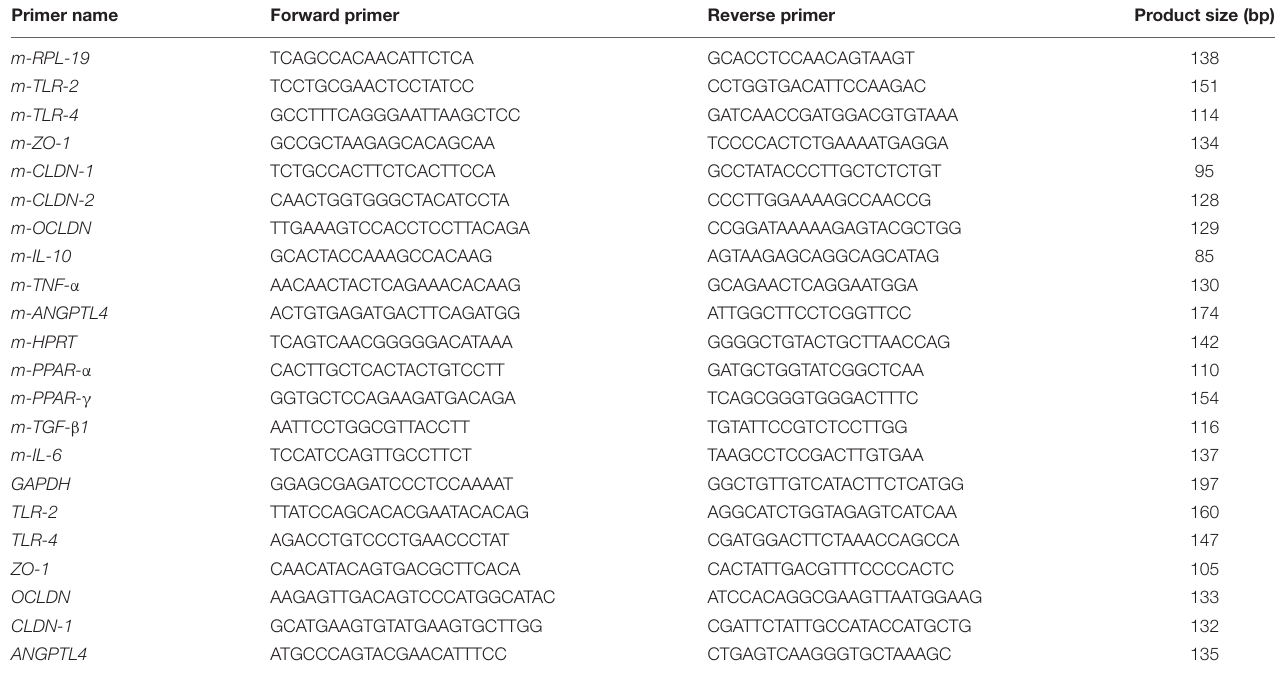
TABLE 2 | Sequence of primers used in qPCR in cell line and